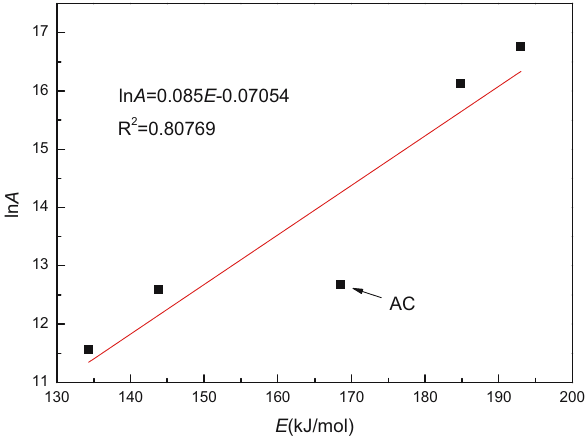
Figure 6: Relation between the values of apparent activation energy and preexponential factor for di ff erent biochars